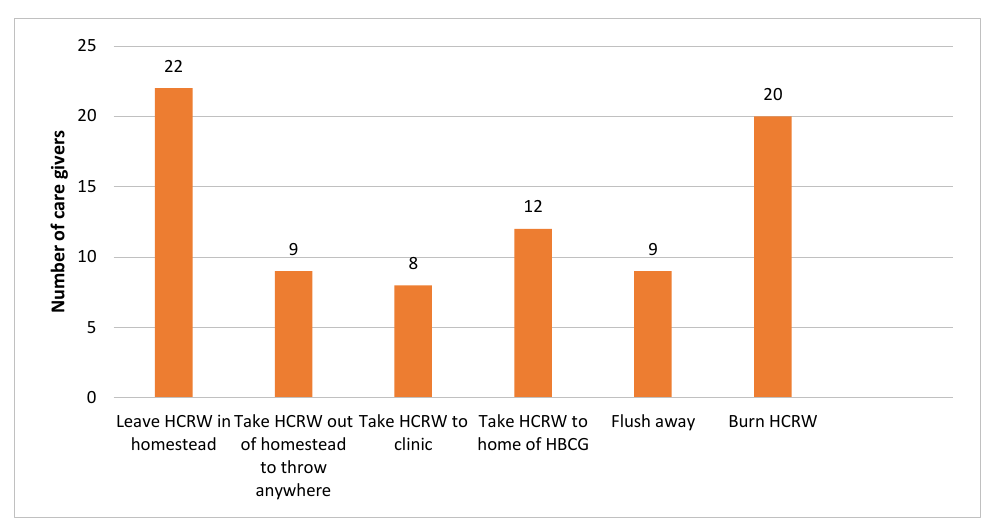
Figure 3. Training. 4. Discussion 4.1. Demographics The findings revealed that home-based care is mostly offered by middle-aged women. This is because the services offered are physically demanding and not suitable for the elderly to administer.